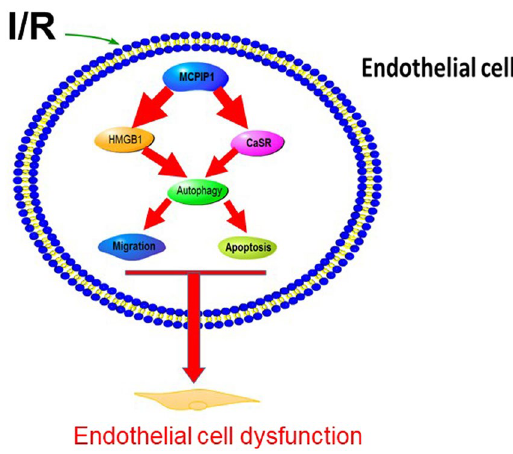
Figure 7. Schematic model of the mechanism by which HMGB1, CaSR, and autophagy promote I/R-induced endothelial cell